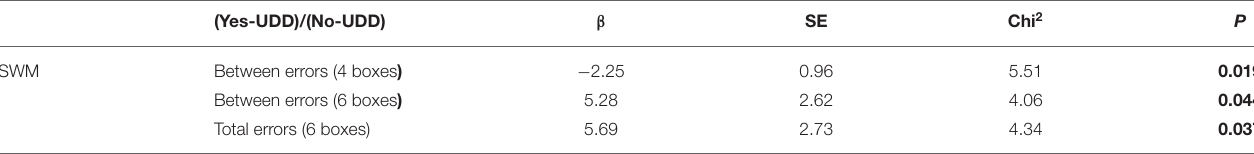
TABLE 4 | Results of GEE analysis regarding the effects of depression types and response to treatment on CANTAB scores (BDD responders vs. BDD Non-responders). (Yes-BDD)/(No-BDD) β SE Chi 2 SWM Between errors (working memory) Total errors (between errors + within errors–double errors) OTS Problems solved on first